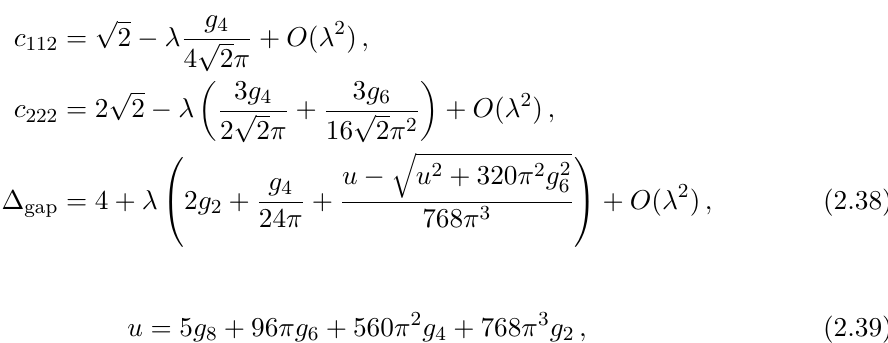
Figure 6 . The space of allowed values for ( c 112 , c 222 ) for ∆ 1 = 1 and ∆ 2 = 2 and ∆ gap taking the values 3 (outermost yellow), 3.2 (red), 3.3, 3.6 and ultimately 4 (innermost blue). Increasing the number of constraints from Λ = 10 to Λ = 30 shrinks all the regions. The red point corresponds to the generalized free field